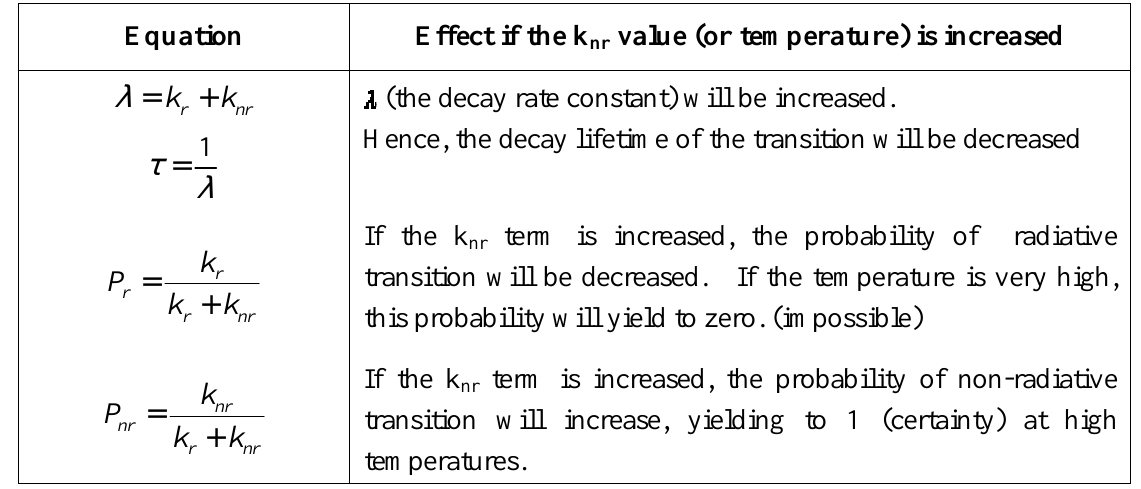
Table 6: Effect of increasing temperature on the probability of radiative (P radiative (P ) decay. nr